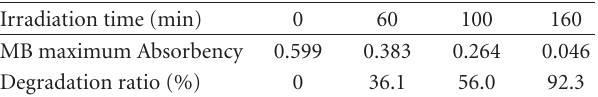
Table 1: The maximum absorbency of MB during the photodegra- dation progress.